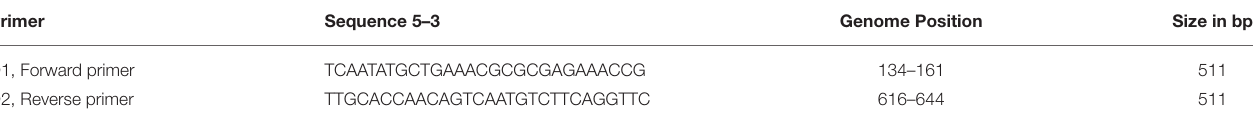
TABLE 1 | Oligonucleotide primers used in reverse transcription-polymerase chain reaction (RT-PCR).